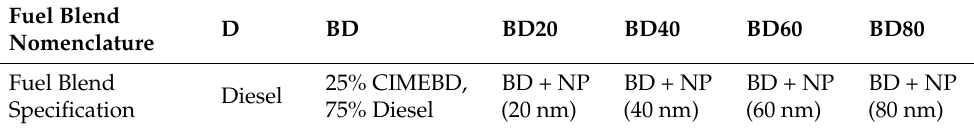
Table 4. Fuel Blends and Nomenclature.